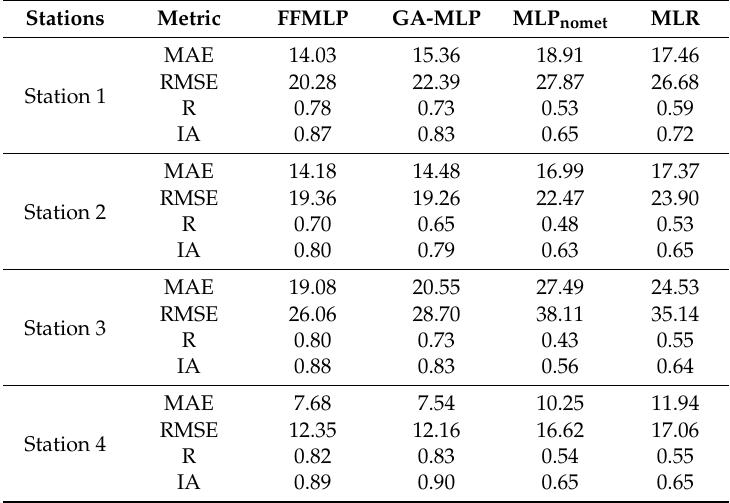
Table 18. Performance indicators for the developed forecast models.